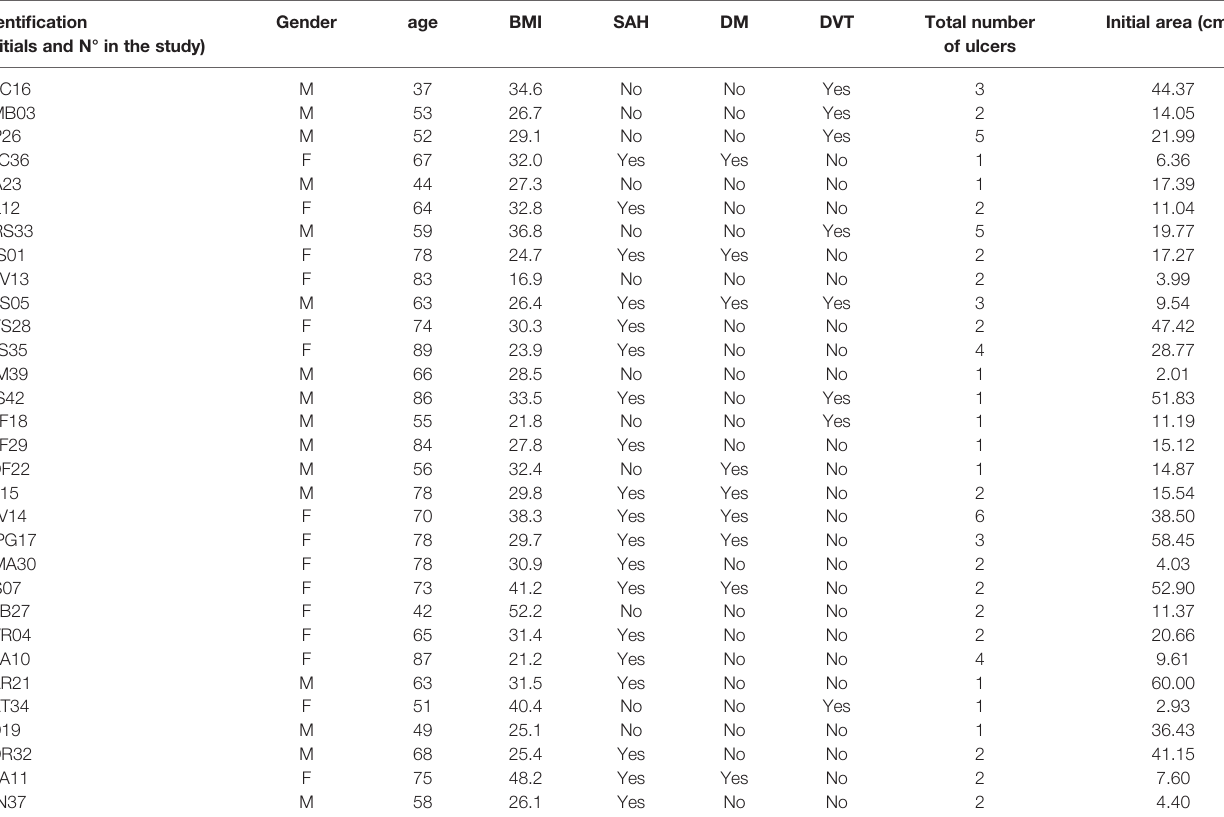
TABLE 1 | General characteristics of the 31 participants included in the study at baseline. Identi fi cation (initials and N° in the study)